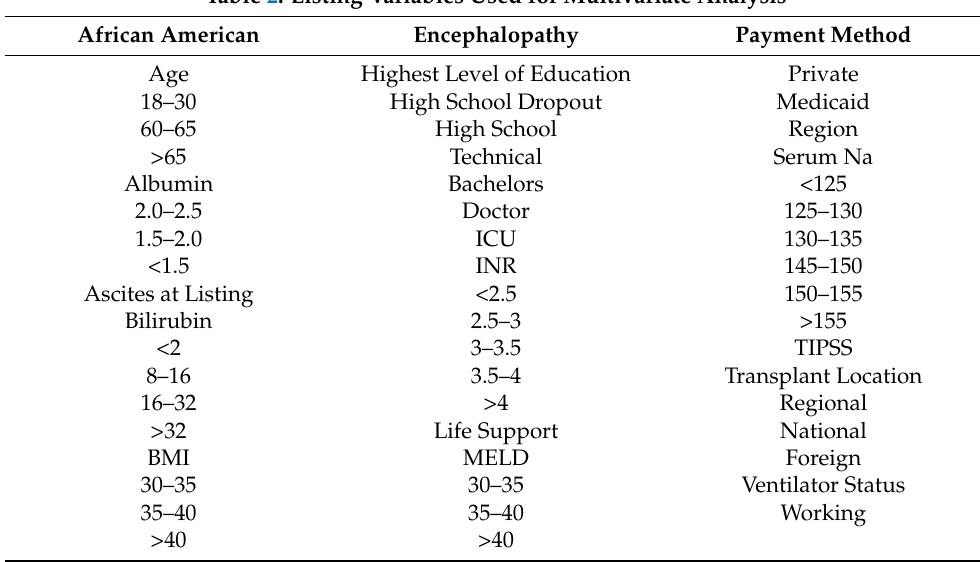
Table 2. Listing Variables Used for Multivariate Analysis. Table 2: Listing Variables Used for Multivariate